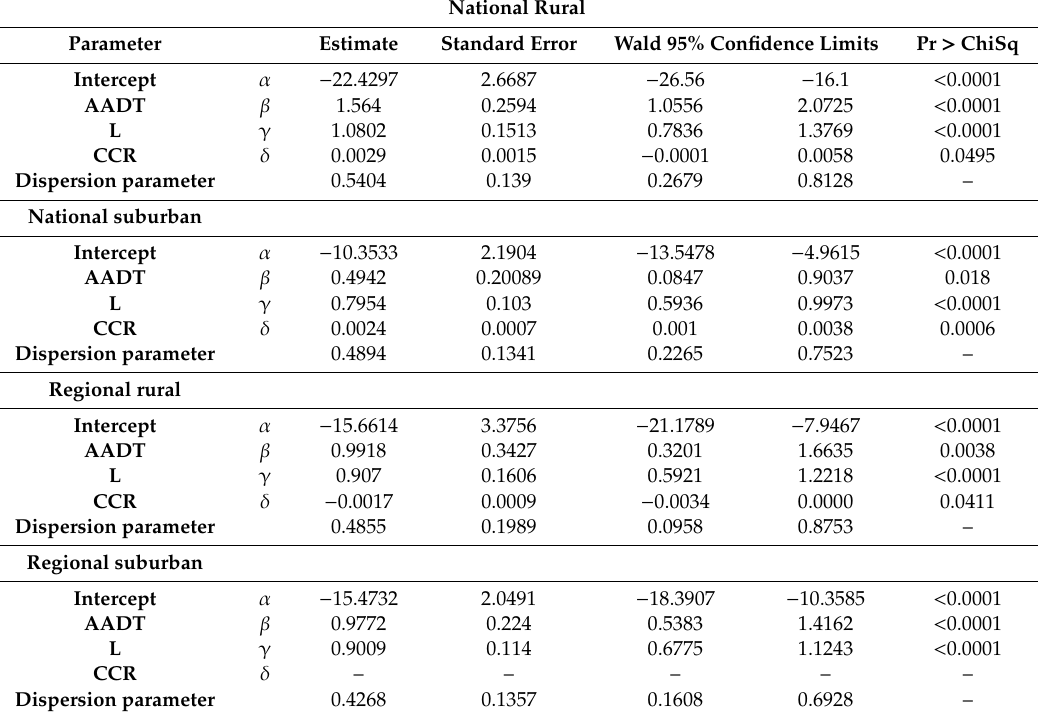
Table 5. Regression coe ffi cient, standard error, and p-value of the Safety Perfomance Functions (SPFs) for road segments.